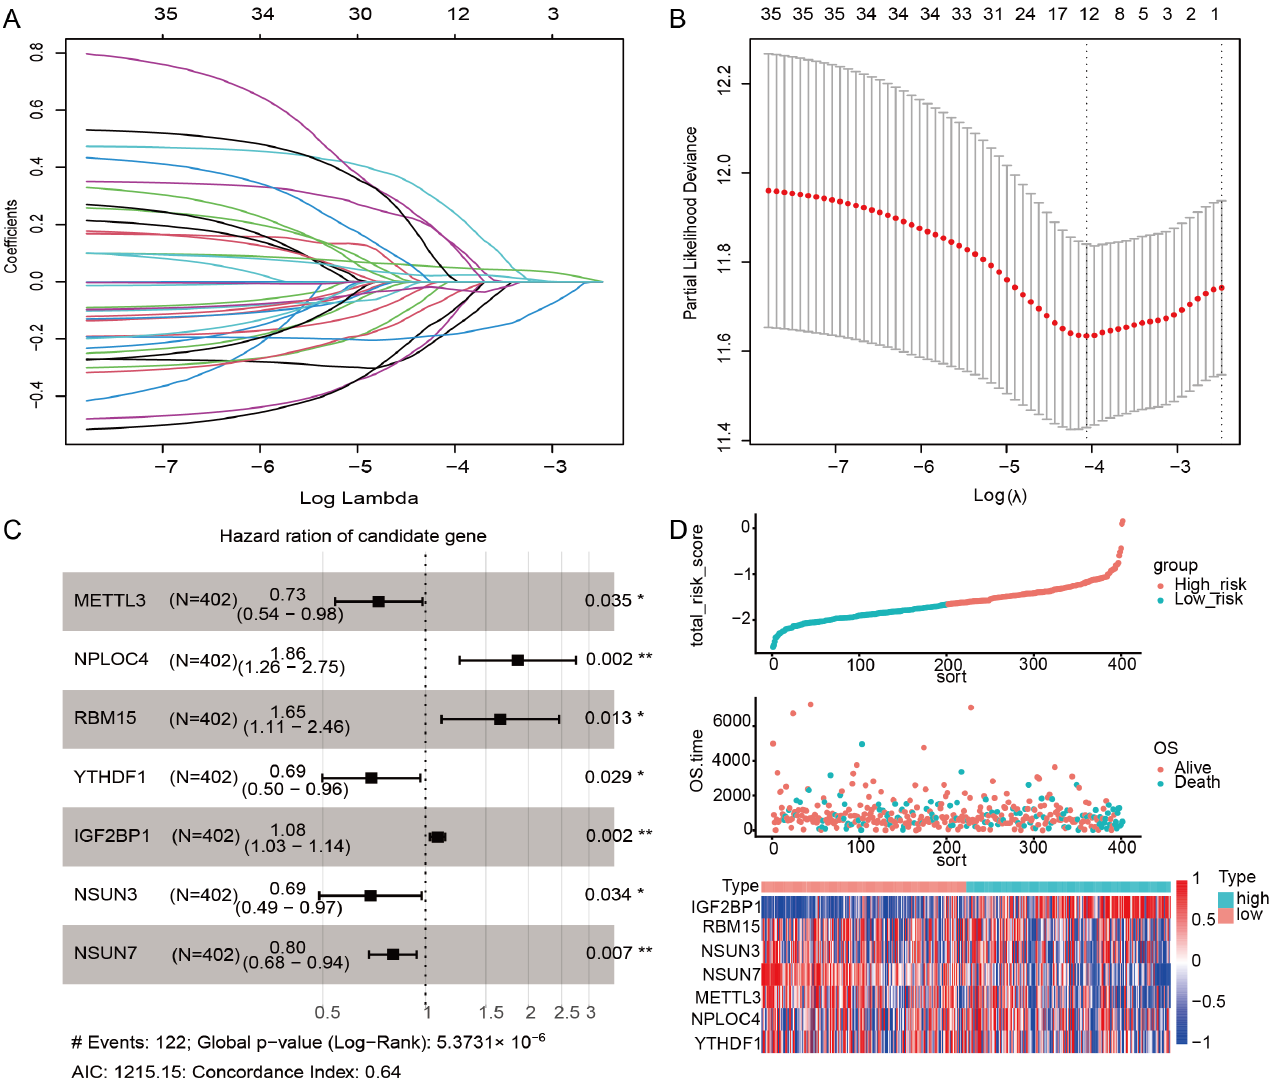
Figure 6. Construction of the m6A/m5C-related prognostic model. ( A ) The trajectory of 37 m6A/m5C regulatory genes, wherein the horizontal axis represents the log value of m6A/m5C regulatory genes lambda, and the vertical axis represents the coefficient of m6A/m5C regulatory genes. ( B ) LASSO coefficient profiles of 11 selected m6A/m5C regulatory genes in a 10-fold cross-validation. The vertical dotted lines were drawn at the optimal values by using the minimum criteria and 1-SE criteria. ( C ) The forest plot of the associations between the expression of seven prognostic molecules and OS in the early-stage TCGA-LUAD training cohort. ( D ) The risk score, survival status, and the expression of seven genes in early-stage TCGA-LUAD training set. *, p < 0.05; **, p < 0.01; #, footnote for the